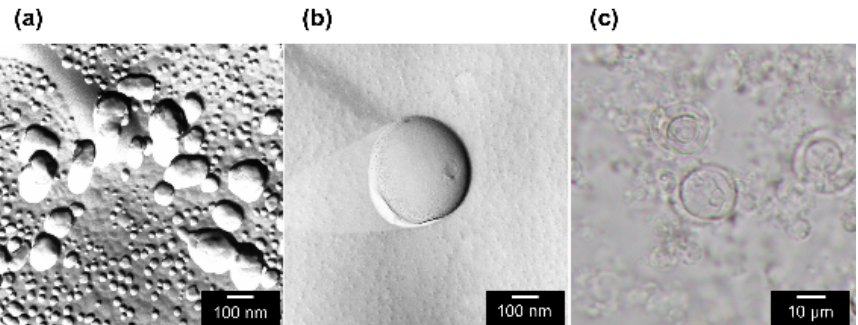
Figure 1. Confirmation of the vesicle formation for 1-stearoyl-2-oleoyl-phosphatidylcholine (SOPC). ( a ) Freeze-fractured transmission electron microscope (FF-TEM) image of small unilamellar vesicle (SUV); ( b ) FF-TEM image of large unilamellar vesicle (LUV); ( c ) optical microscope image of giant unilamellar vesicle (GUV).